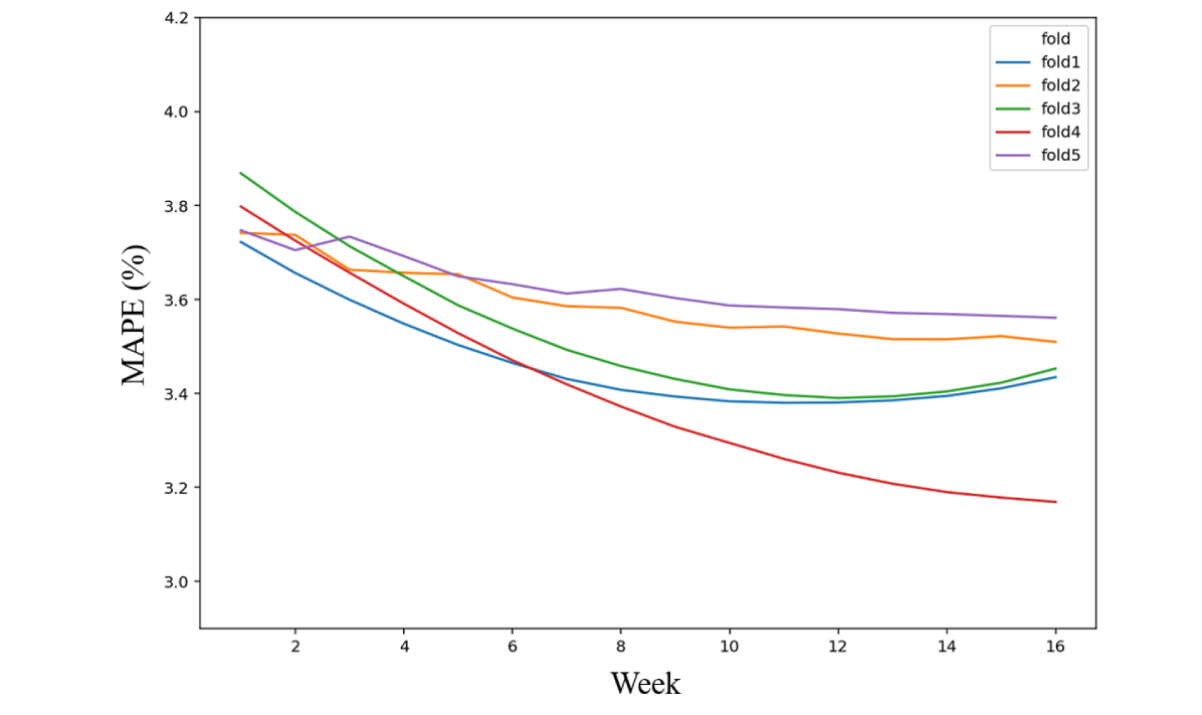
Figure 3. Mean absolute percentage error (MAPE) of model in each 5-fold cross-validation.